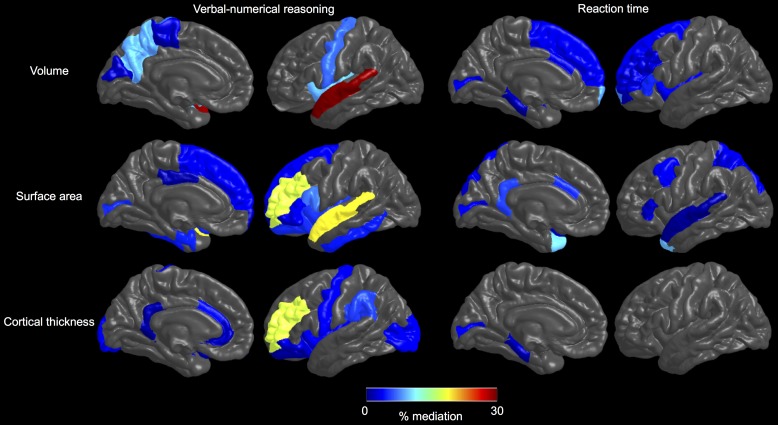
Percentage of the sex-cognitive relation mediated by each of the brain regions selected in a LASSO model to be linked to either verbal-numerical reasoning (left column) or reaction time (right column). Results for volume, surface area, and cortical thickness are shown in each row. Regions were averaged across the hemispheres; thus only a medial and lateral view for each measure and each cognitive test is shown.